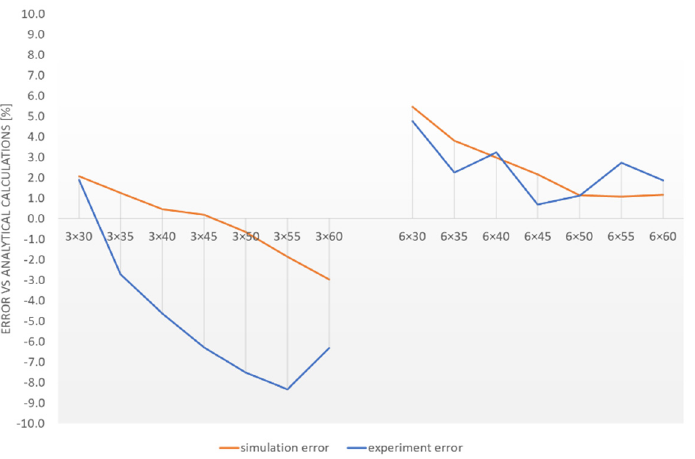
Figure 8. Per cent error of the numerical and experimental methods versus the analytical method.